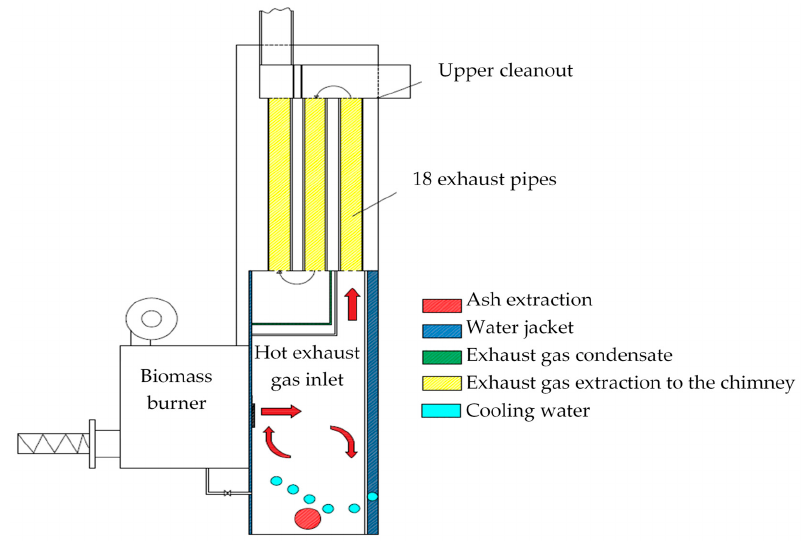
Figure 4. Analyzer burner measurements.